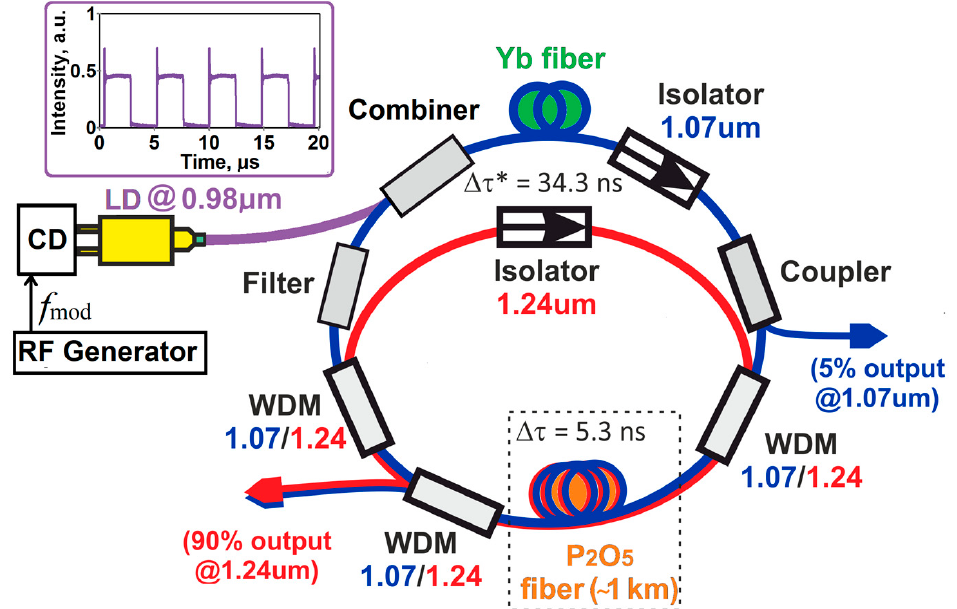
Figure 2. The proof-of-concept experimental laser configuration. LD—current-modulated laser diode for quasi-synchronous primary pumping at 0.98 μ m; CD—current driver; WDMs—wavelength- division multiplexors; ∆ τ and ∆ τ * designate contributions to the overall DGD from the P 2 O 5 -doped fiber and the intracavity bypass. The inset shows the measured time trace of the quasi-synchronously modulated pump power (pumping radiation was accessed via a 1% tap coupler, which is not shown in this